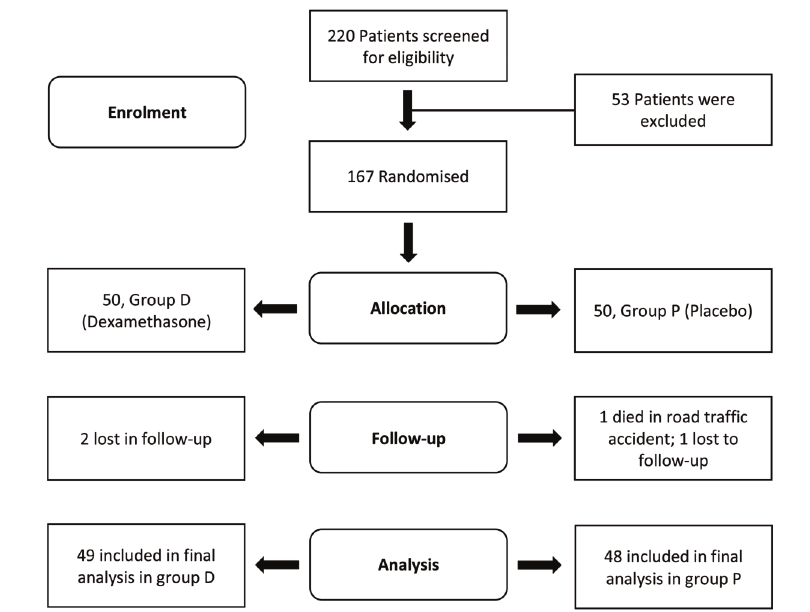
Consolidated Standards of Reporting Trails (CONSORT) flow diagram of patients. Fig. 1: